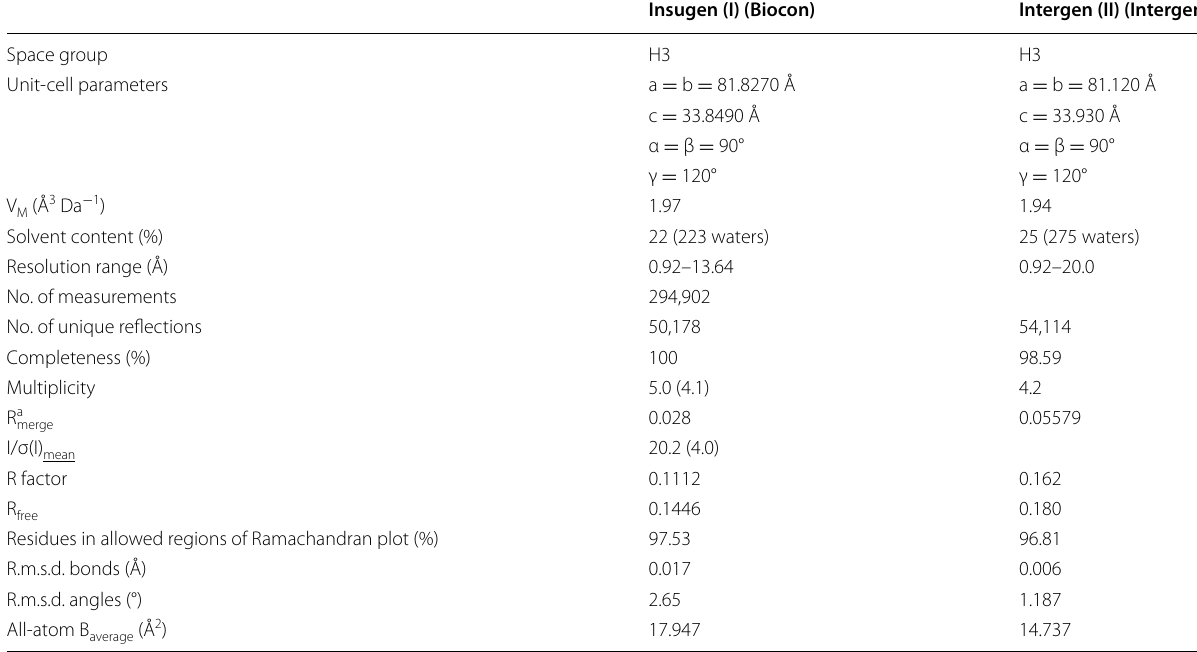
Values in parentheses are for the highest resolution shell a R merge = (cid:31) hkl (cid:31) i | I i ( hkl ) − � I ( hkl ) �| / (cid:31) hkl (cid:31) i | I i ( hkl ) | where I i (hkl) and 〈 I(hkl) 〉 are the observed intensity and mean intensity of related reflections